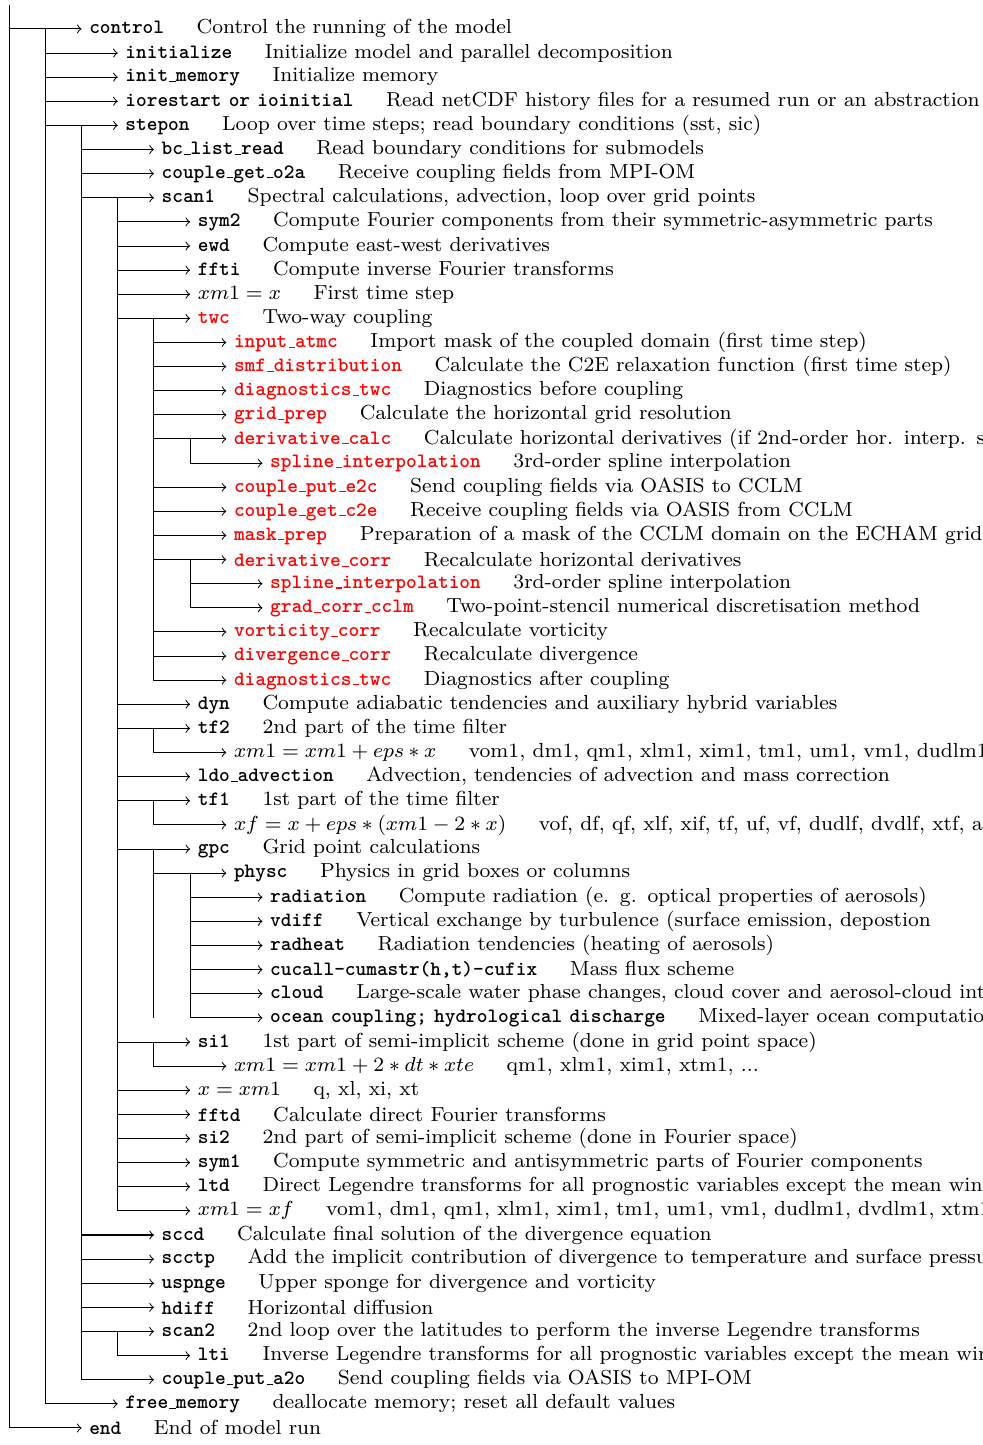
Figure 8. As Fig. 7 but for the ECHAM global atmosphere model of MPI-ESM.